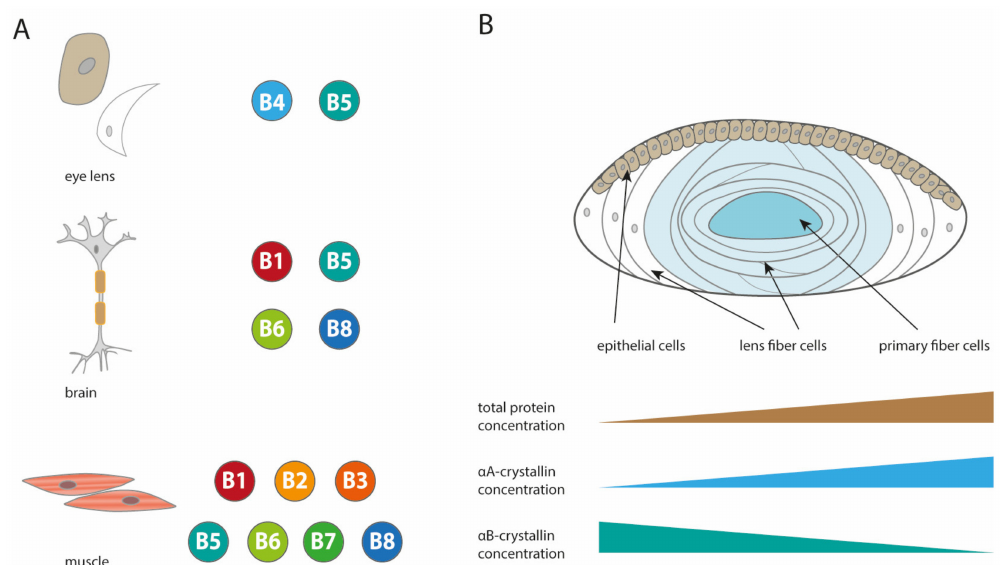
Figure 1. Expression of small heat shock proteins (sHsps) in the eye lens and other tissues. ( A ) Examples of di ff erences in the expression of sHsps (at abundant levels) are shown for a selection of three tissues (eye lens, brain, muscle) [25,54,55]. ( B ) Simplified schematic model of the eye lens, epithelial cells, lens fiber cells (organelle free cells in light blue) and primary fiber cells [56]. Total protein concentration increases within the lens eyes. α A- and α B-crystallin concentration increase or decrease, respectively, during di ff erentiation of bovine lens cells